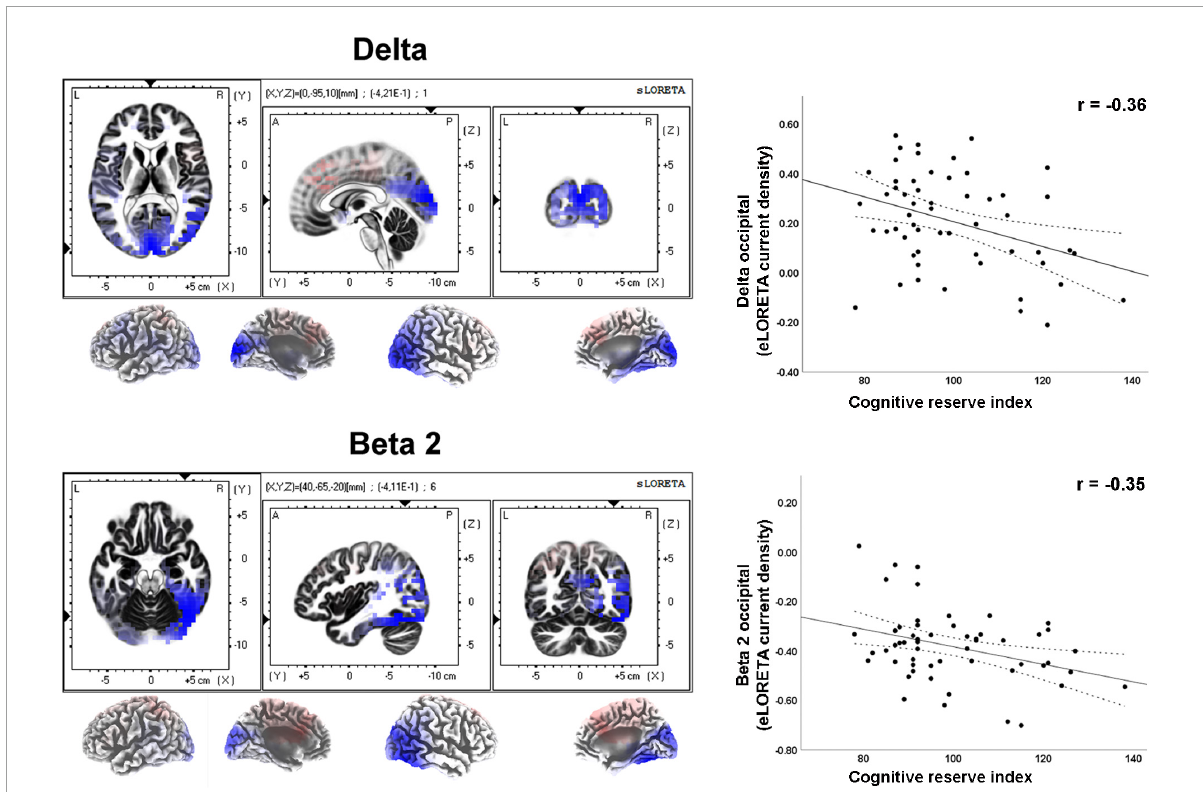
FIGURE3 LORETA images and scatterplots with Pearson’s r for moderate correlations between CSD estimates and the Cognitive Reserve Index ( r ≥ 0.30). The two correlations were negative (blue tones).